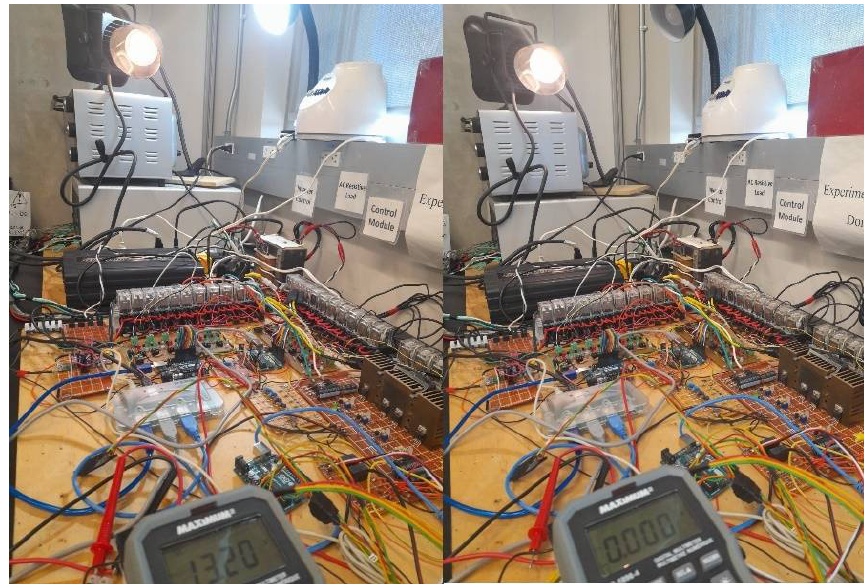
Figure 15. Fail-safe test scenario results on microgrid setup.